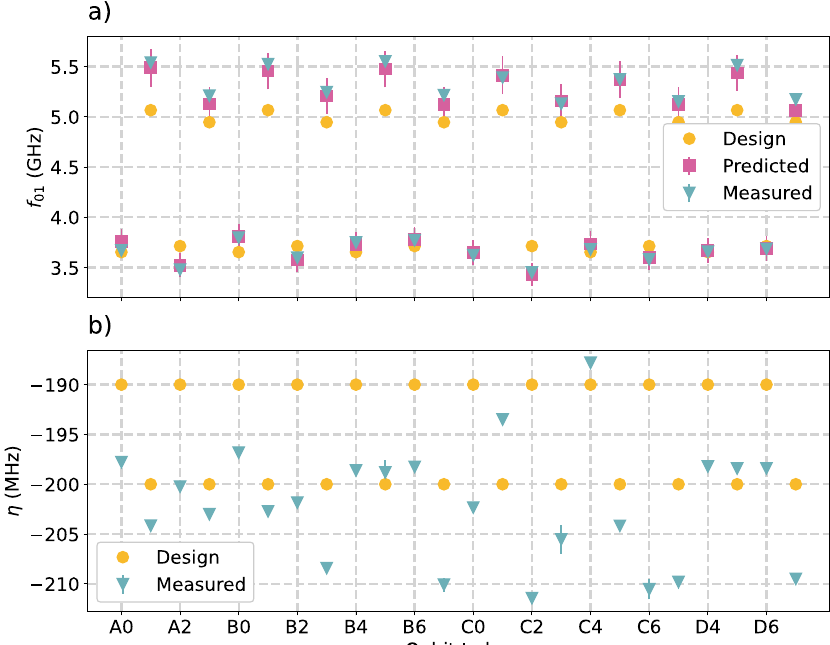
Fig. 5 Comparison of predicted and measured transition frequency, f 01 and anharmonicity, η at zero applied fl ux bias. Note that while the design target is constant from one die to the next (all dies are designed to be identical), small variations in the predicted and measured qubit frequencies are present due to fabrication process variation, which can be measured at room temperature. Good agreement between the predicted and measured qubit frequencies, to within ± 108 MHz, is obtained. Anharmonicities show a systematic offset from the design targets but are still within 11% of the target value. Error bars on the predicted values represent the standard deviation in the values obtained from a Monte – Carlo simulation where the expected variation in the simulation inputs is accounted for (room temperature metrology error, error in the qubit charging energy, etc).